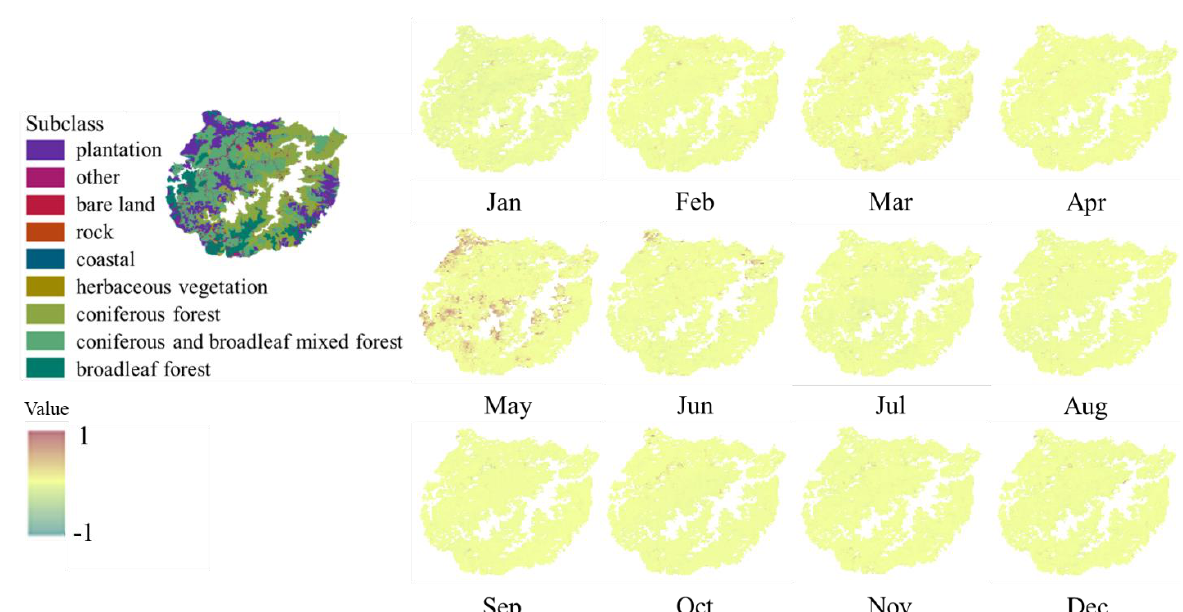
Figure 8 The differences between the predicted and observed NDVI in